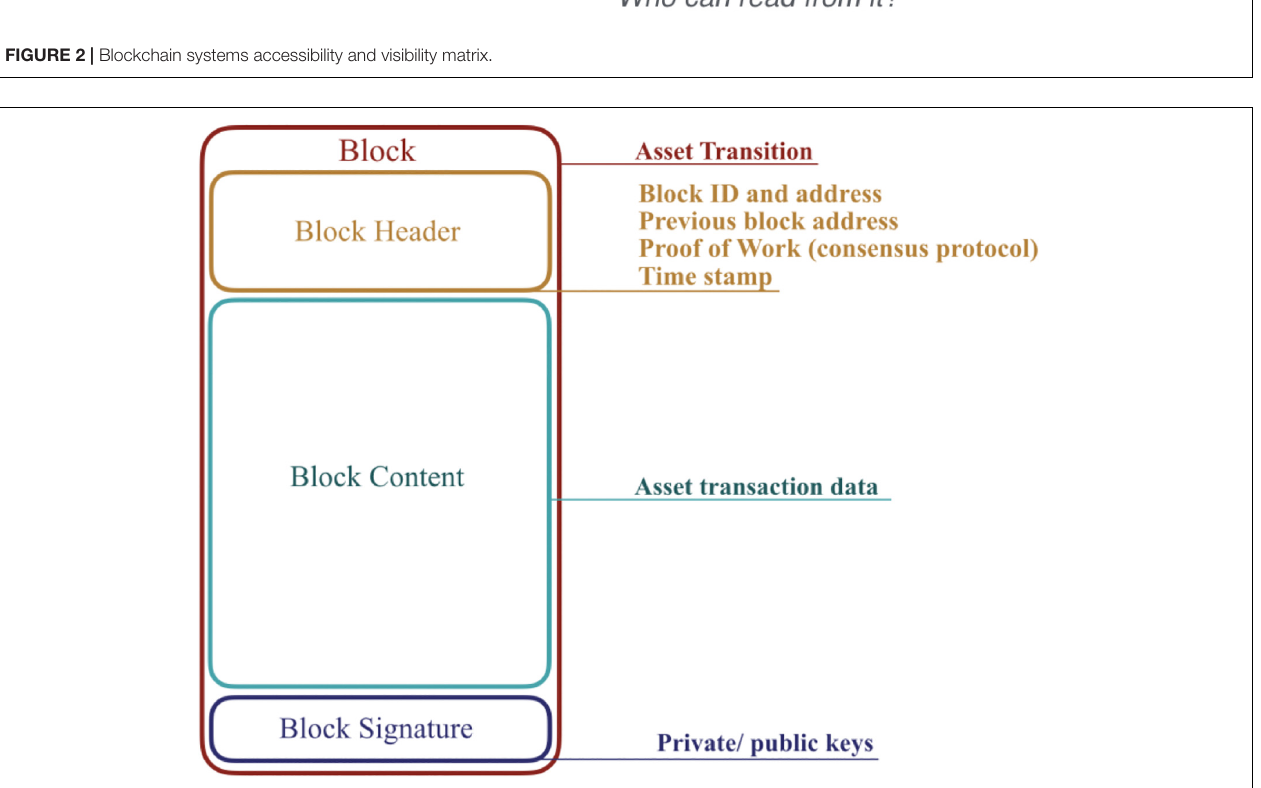
FIGURE 3 | Common block anatomy for all blockchain use case